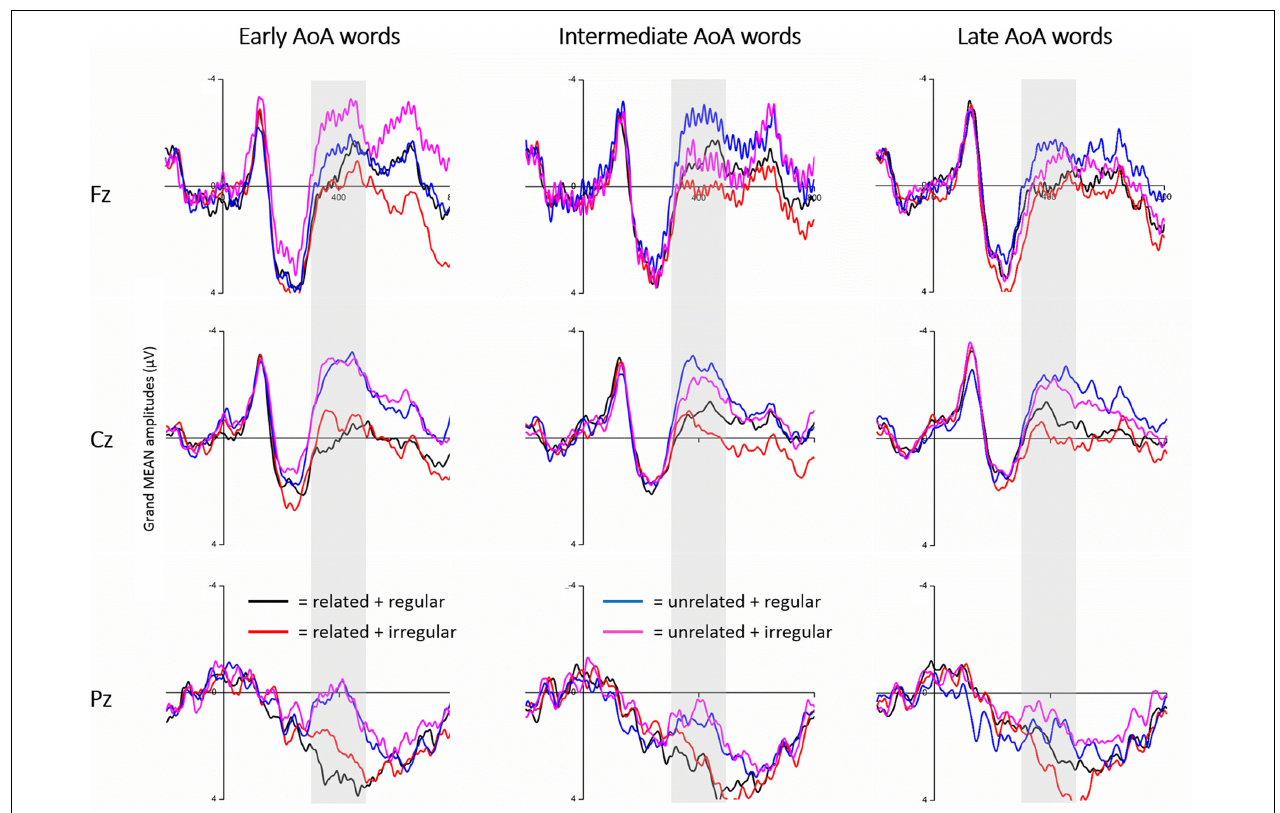
FIGURE 3 | Mean amplitudes in Fz, Cz, and Pz during processing words of different AoAs. The 350–450 ms post stimulus is signaled by the gray